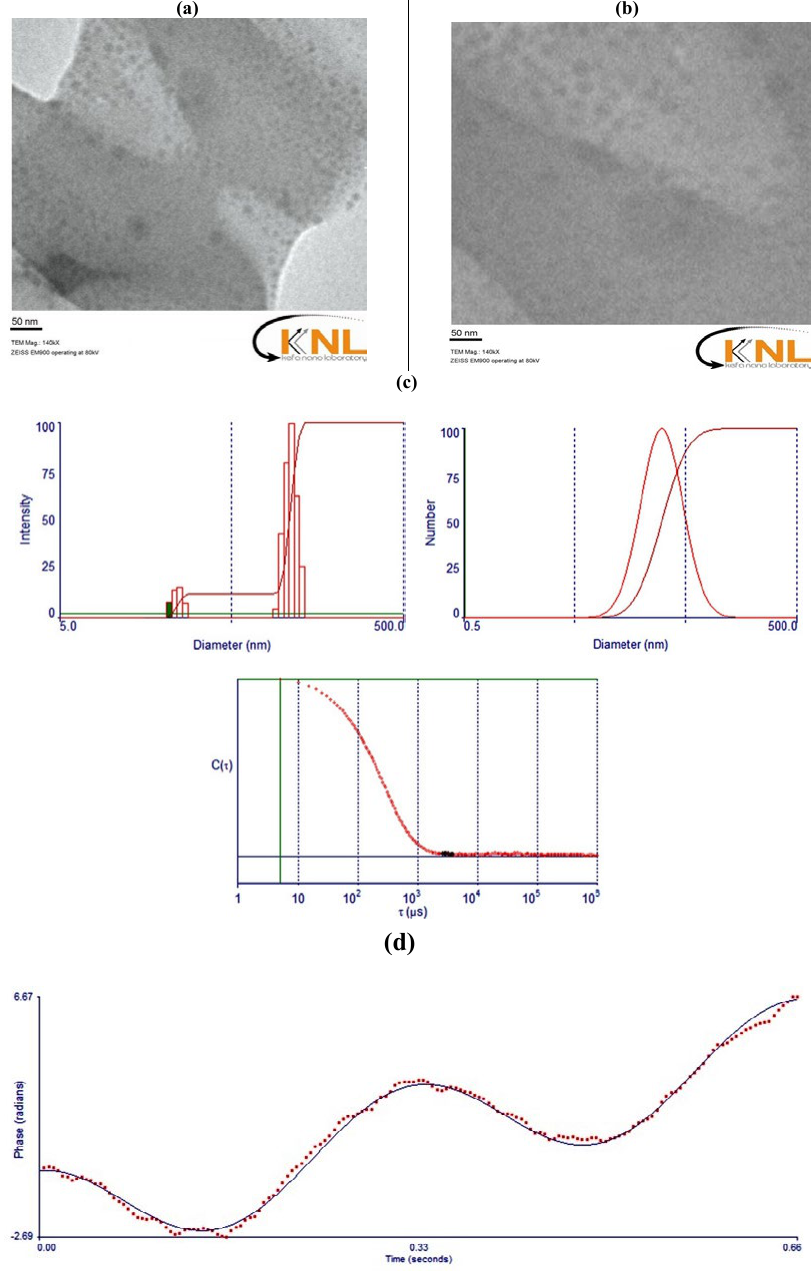
Fig. 2: TEM images of (a) Fe-MoII, (b) Fe-MoIII, (c) DLS results of size distributions, log normal size distributions, C(τ) of Fe-MoII, and (d) zeta potential of Fe-MoII